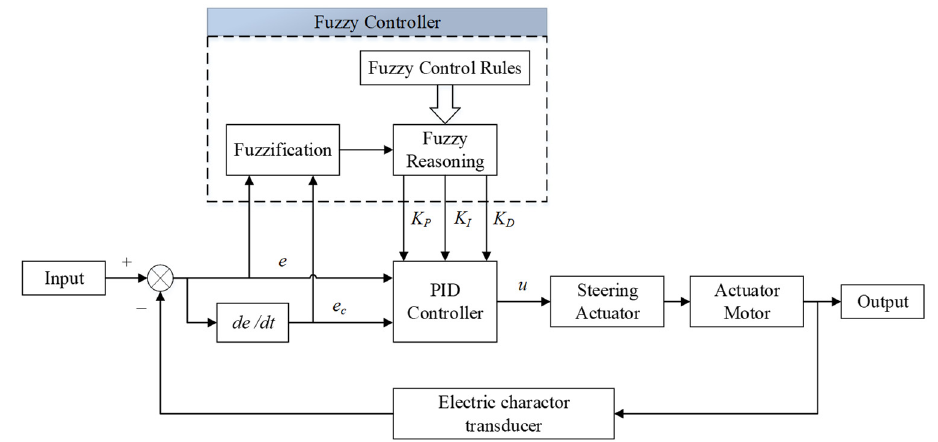
Figure 6. Fuzzy PID control structure of deflection control system.